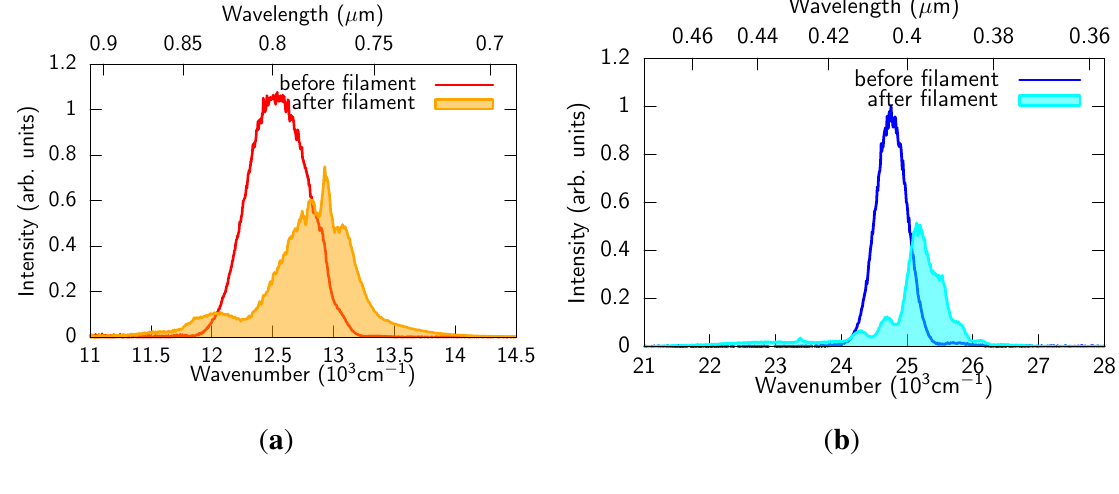
Figure 2. ( a ) Fundamental spectra measured before and after the filament (solid and filled curves, respectively). The spectrum did not change when the delay time between the fundamental and the SH pulses was adjusted; ( b ) SH spectra when the delay time between the fundamental and the SH pulses was not adjusted (solid curve) and was adjusted (filled curve).